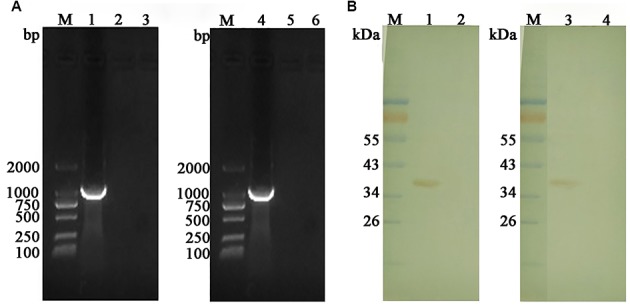
Transcription and expression detection of GAPDH by RT-PCR and Western blot in the injected muscles. (A) Transcription detection of GAPDH by RT-PCR; M: DL2000 DNA marker; lane 1: product of EaGAPDH from pVAX1-EaGAPDH injected muscle; lane 4: product of EmGAPDH from pVAX1-EmGAPDH injected muscle; lanes 2 and 5: pVAX1 injected control; lanes 3 and 6: non-injected control; (B) Expression detection of GAPDH by Western blot; M: Standard protein molecular weight marker; lane 1: protein band of 37.4 KDa recognized by anti-EaGAPDH rat serum from the muscles injected with pVAX-EaGAPDH; lane 2: non-injected muscle recognized with anti-EaGAPDH rat serum; lane 3: protein band of 37.4 KDa recognized by anti-EmGAPDH rat serum from the muscles injected with pVAX-EmGAPDH; lane 4: non-injected muscle recognized with anti-EmGAPDH rat serum.